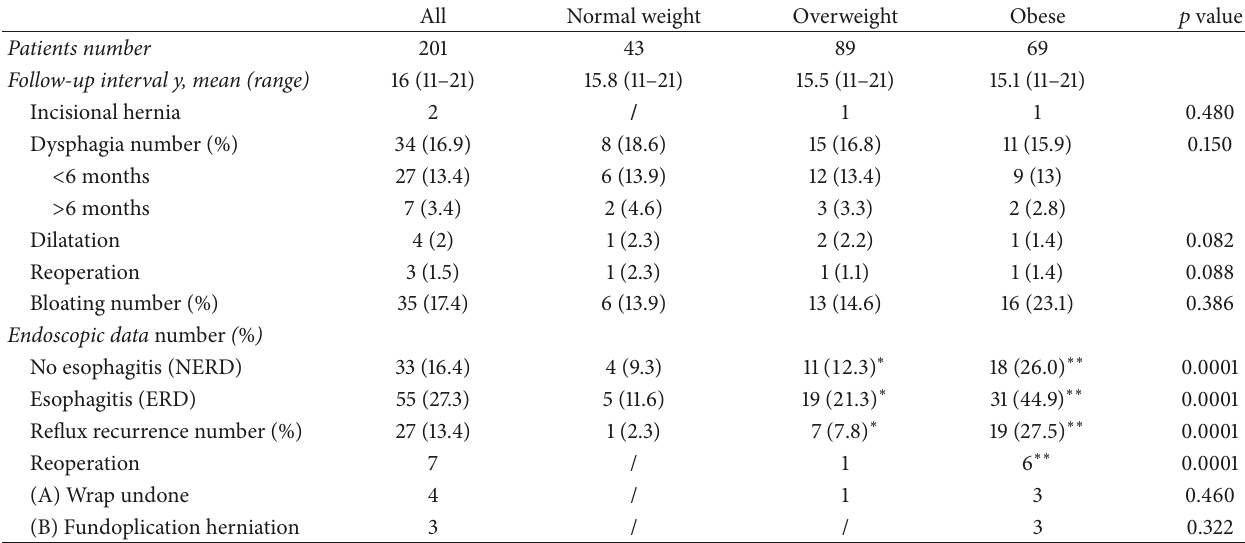
Table 4: Long-term follow-up data.